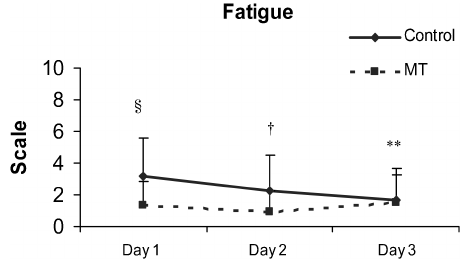
Figure 3 - VAS of fatigue assessed at the postoperative period on Day 1, Day 2 and Day 3. 1 comparison intergroup on Day 1; + comparison intergroup on Day 2; ** comparison between Day 1 and Day 3 for control groups. (p